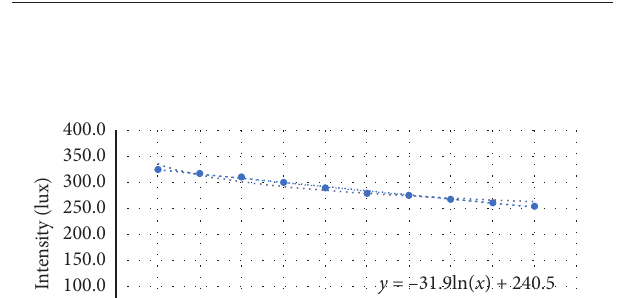
Figure 6: Calibration curve for absorbance of known BSA-normal saline solutions.